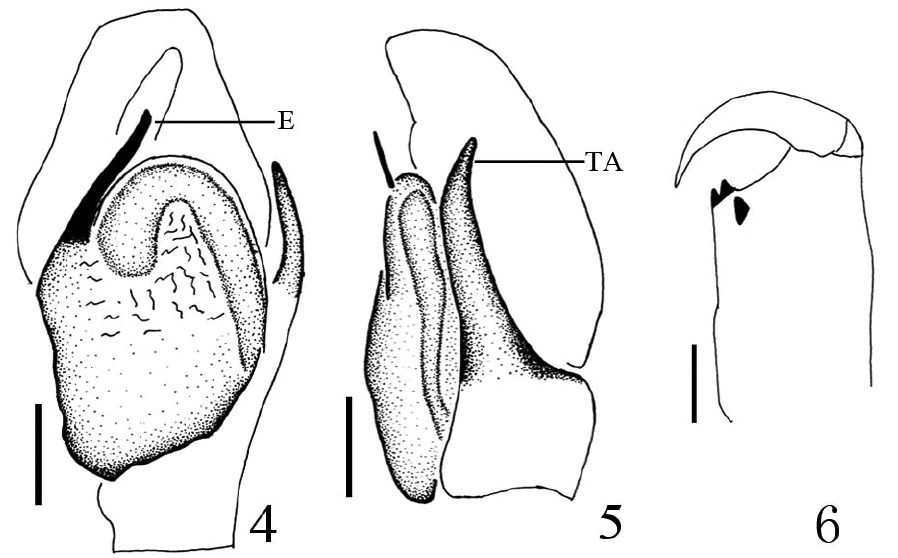
Figures 4–6. Yaginumaella lushuiensis sp. n. 4 male palp ventral view 5 male palp, retrolateral view 6 left chelicera, posterior view. Scale bars: 0.1 mm.